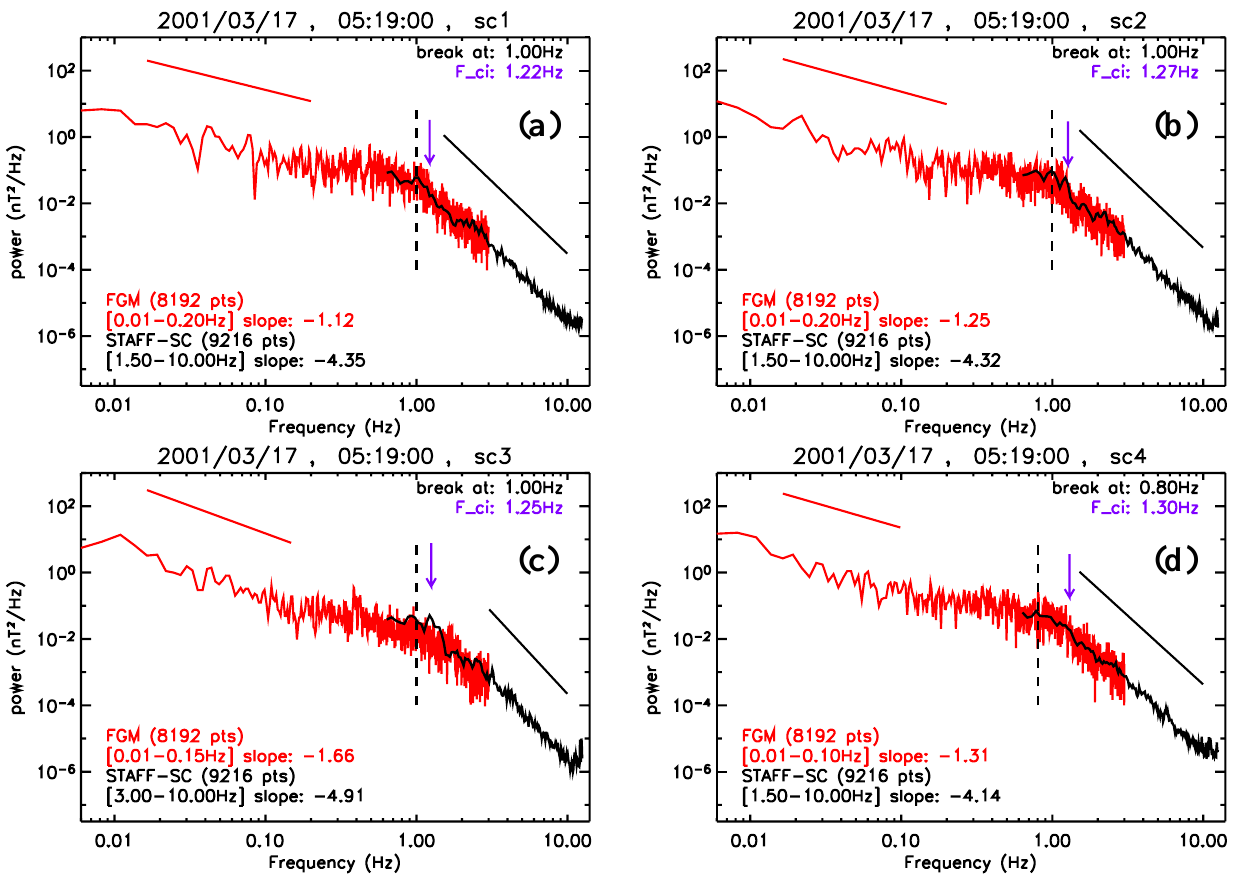
Fig. 3. The power spectrum of magnetic field fluctuations observed by Cluster FGM (red) and STAFF (black) instrument at interval centered at 05:19 UT by sc1 (a) , sc2 (b) , sc3 (c) , and sc4 (d) . Power law slopes are shown above the spectra, and their methods of evaluation are discussed fully in the text. The spectral breakpoint is marked with black vertical line and local f IC with purple arrow.